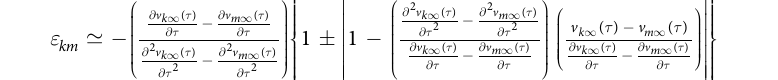
Using the generalized binomial expansion